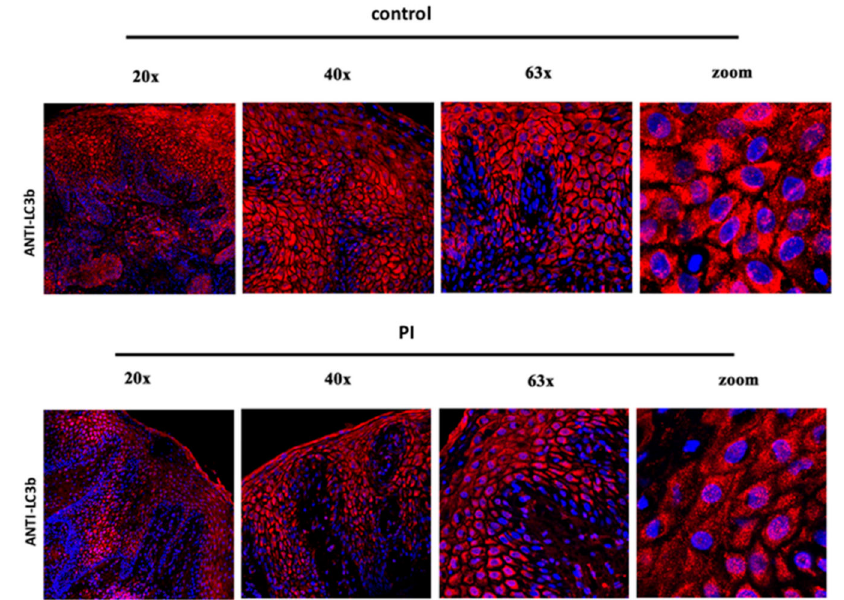
Figure 4. Immunofluorescence against autophagy processes in keratinocytes in control and PI samples. In all samples, positivity (in red) confirms the activation of the autophagy process during maturation of